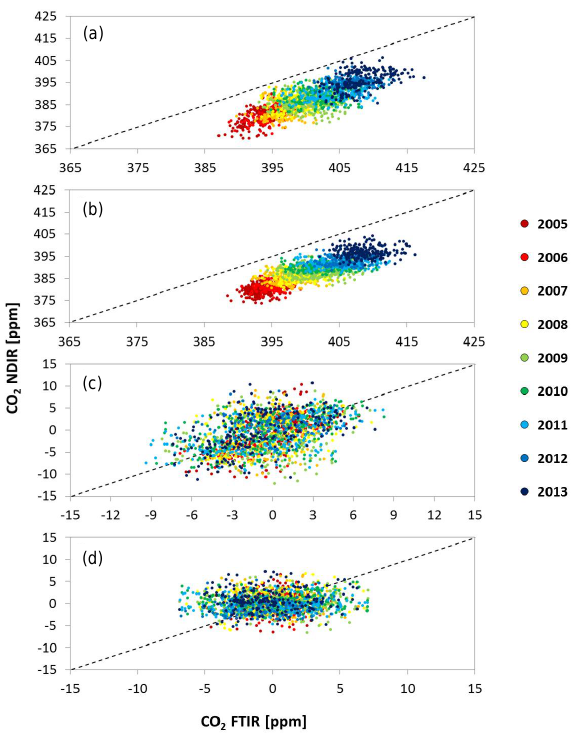
Figure 10. Correlation plots of the filtered hourly NDIR CO 2 mea- surements vs. the filtered FTIR CO 2 measurements. The different colors refer to the years 2005 to 2013 (see legend). (a) The NDIR CO 2 measurements vs. FTIR CO 2 measurements including both, the annual CO 2 increase and the seasonality; (b) as (a) but without seasonality; (c) as (a) but detrended; (d) as (a) but with neither an- nual CO 2 increase nor seasonality. The dashed line is the 1:1 line.